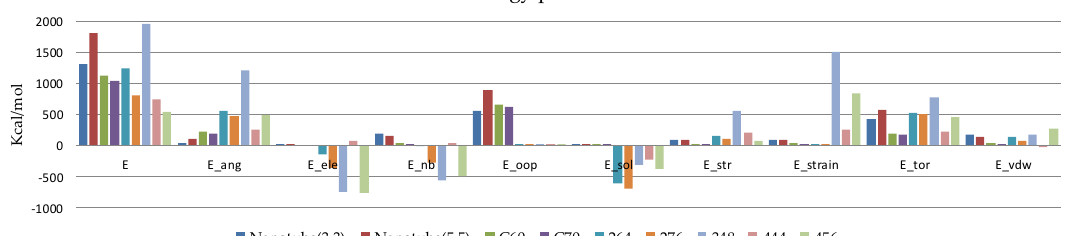
Figure 8. The energy profile (in kcal/mol) of the compounds listed in Table 3. Used abbreviations: E – potential energy; E_ang – angle between potential energy; E_ele – electrostatic component of potential energy; E_oop – out of plane potential energy; E_sol – solvation energy; E_str – bond stretch potential energy; E_strain – local strain energy; E_tor – torsional potential energy; E_vdw – van der Waals component of potential energy.